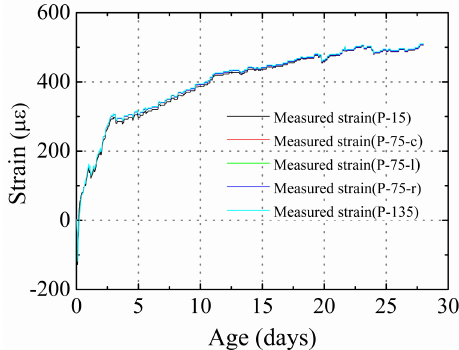
Figure 5. Measured autogenous shrinkage strain in the P